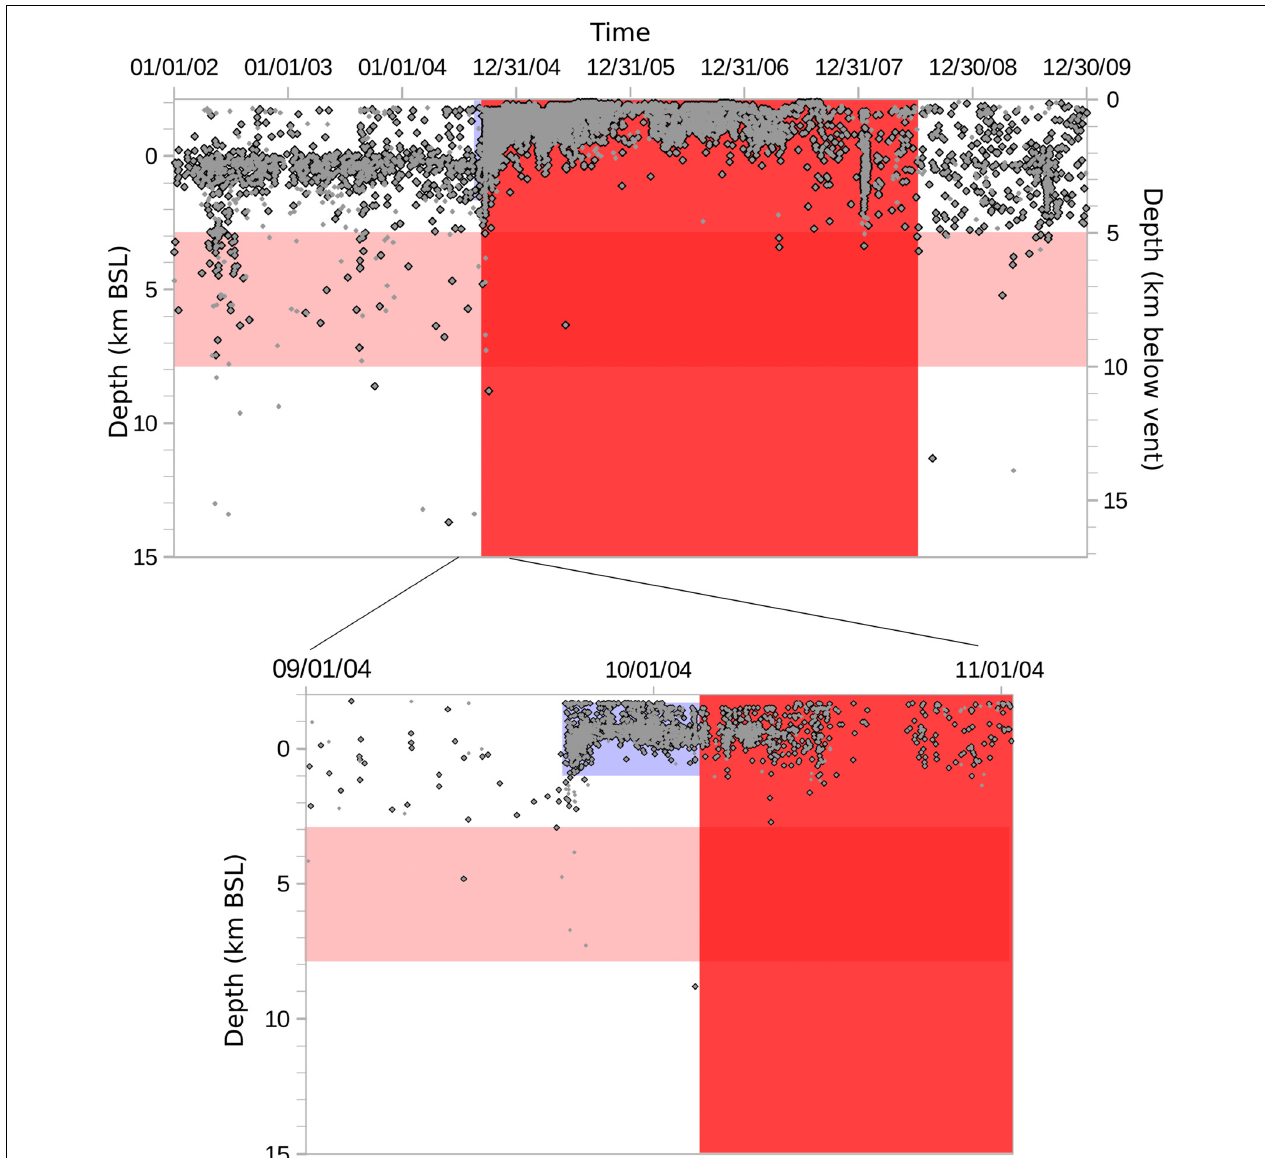
FIGURE 7 | Time-depth plot for Mt. St. Helens, Washington, from January 2002 to December 2009. Light red – petrologically-defined magma source. Dark red – eruptions. Light blue shading shows the timing and depth of precursory seismicity. Gray dots show all earthquakes and black outlined dots show earthquakes with well-constrained locations. Inset panel shows detail of the runup and eruption onset. Earthquake data: University of Washington (1963) and Cascades Volcano Observatory [USGS] (2004).